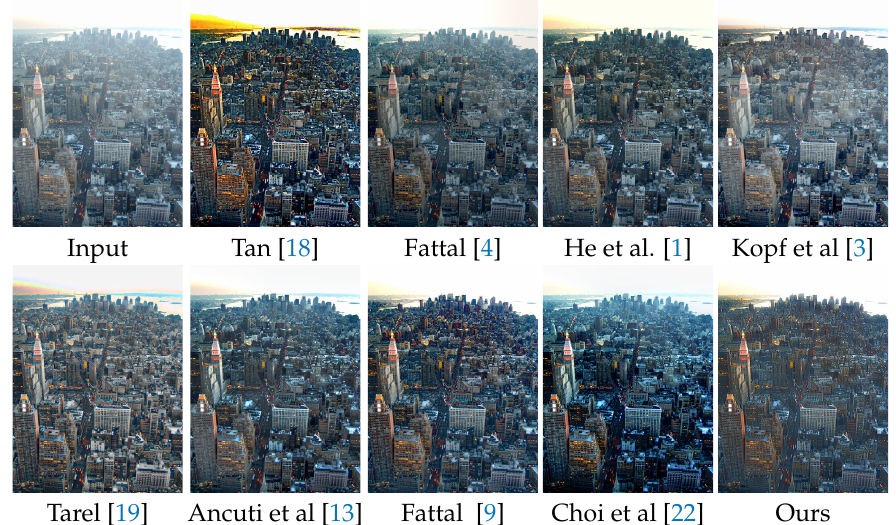
Figure 8. Visual comparisons on a real-world hazy image of “ny12”.